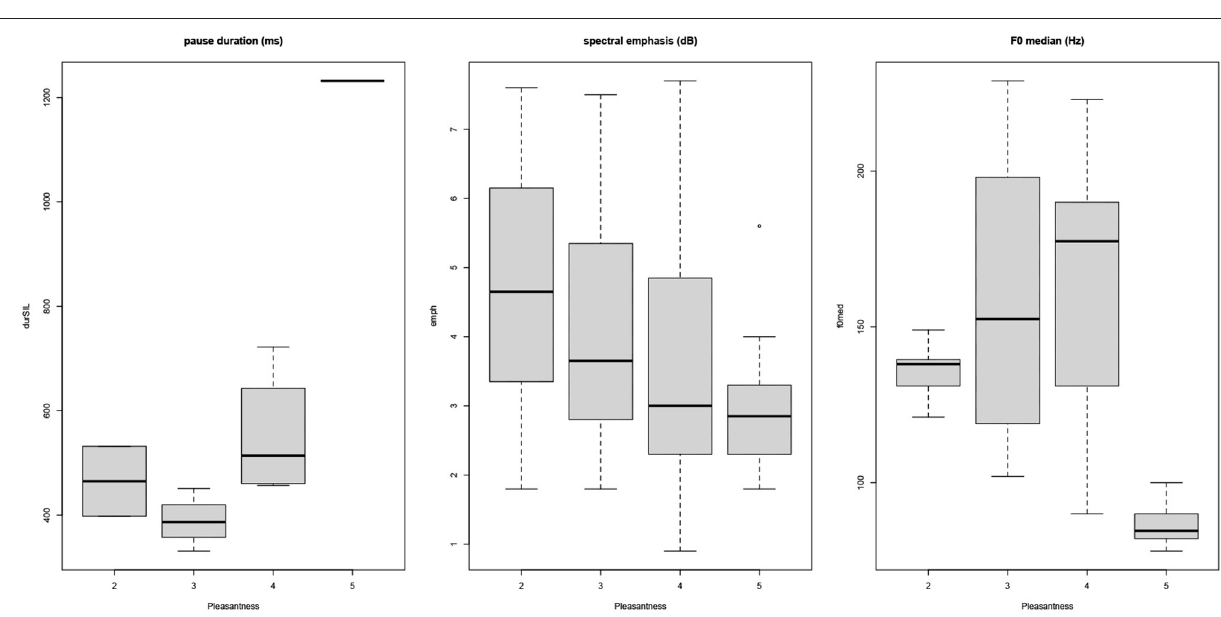
the two models can be checked graphically with the boxplots for the three predictors for the EP dataset in Figure 3